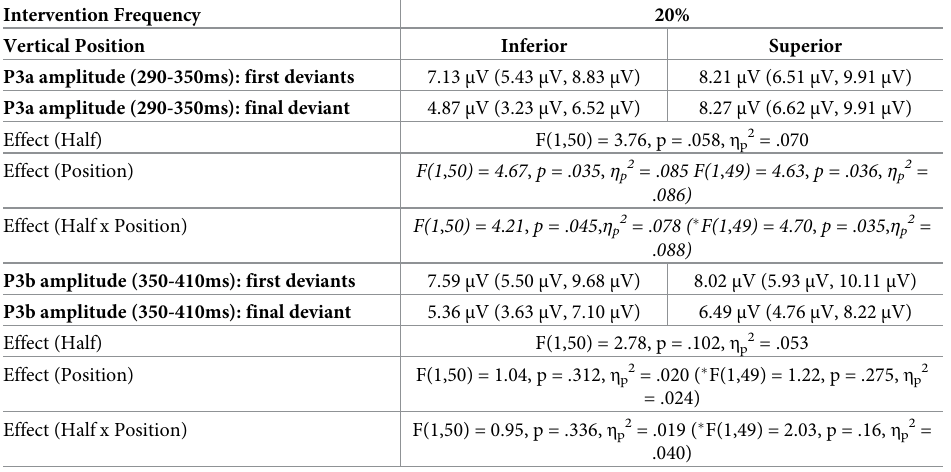
Table 3. Descriptive statistics for the ERP data (intervention frequency 20%) for the non-intended outcome, sepa- rated for, assignment (vertical position: inferior vs. superior) and half (first and final deviants within a block). To each mean, the upper and lower limits of confidence intervals (95%) are additionally provided in brackets. ANOVA results for the factor vertical position are additionally controlled for the covariate ’age of participant’ in an ANCOVA. All ANCOVA results are indexed by an asterisk ( �